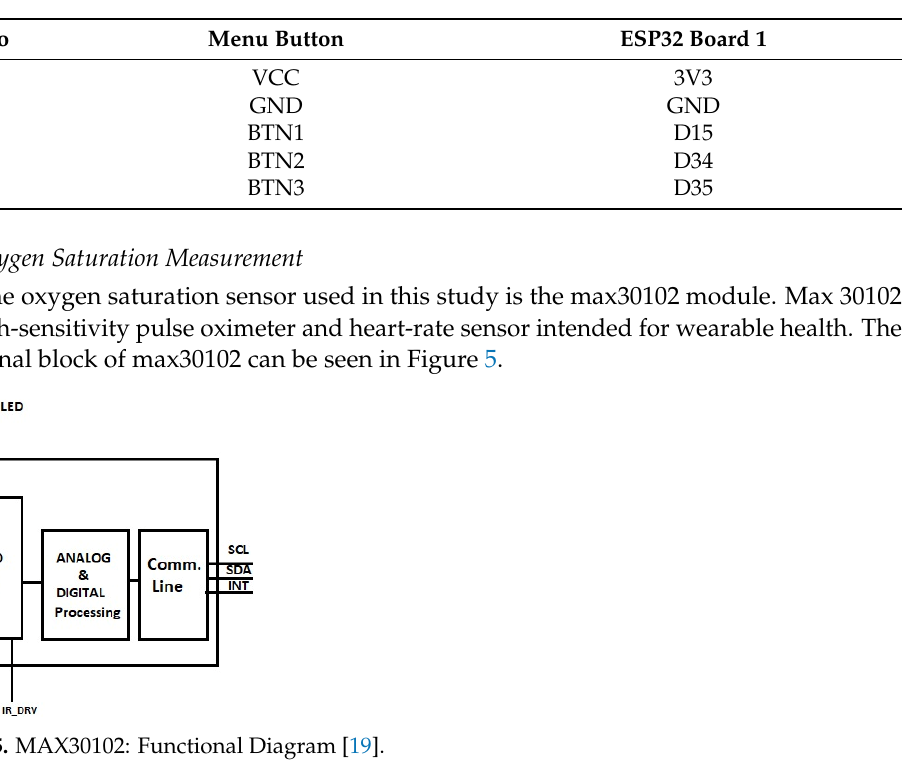
Figure 4 . Buttons in the system. Figure 4. Buttons in the system.